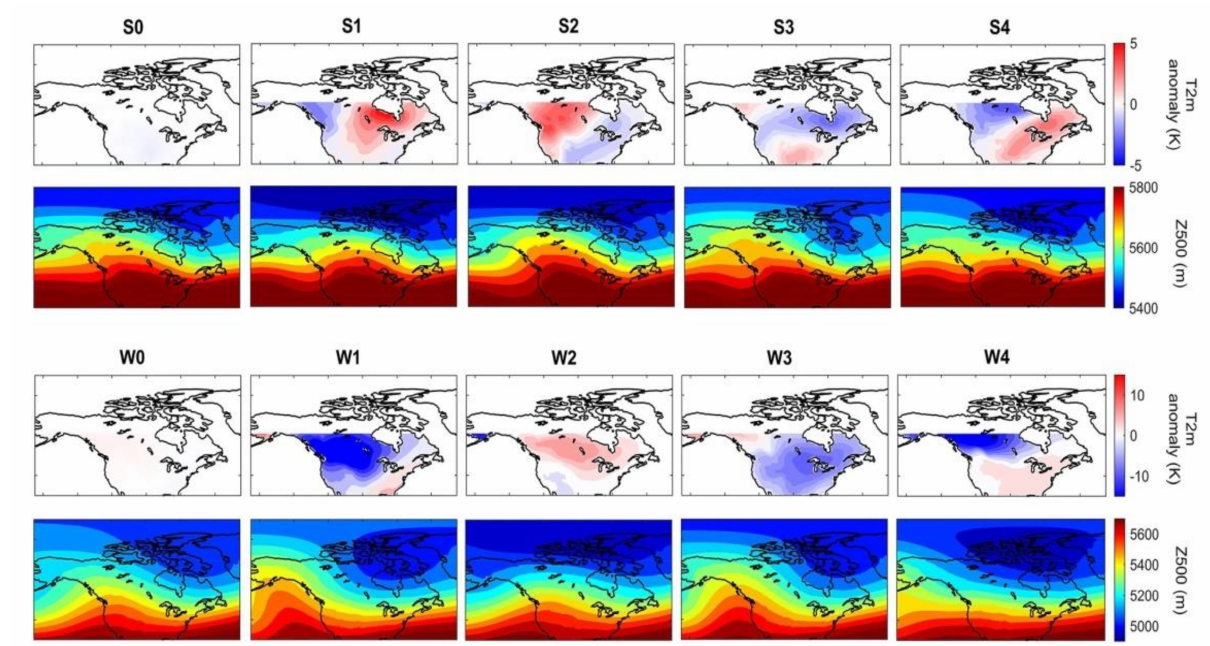
Figure 8. Distribution of extreme weather for summer and winter